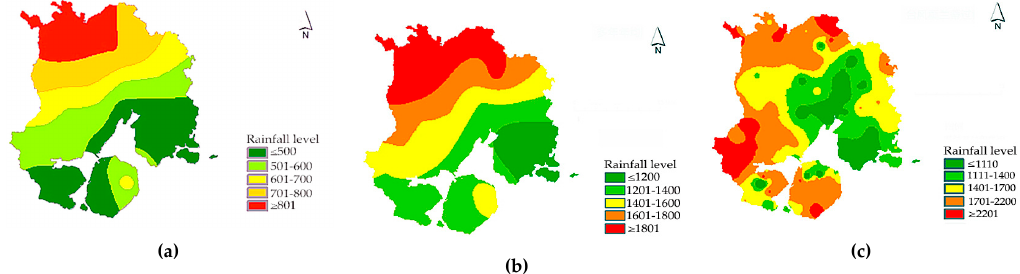
Figure 2. Simulation of precipitation in different scenarios in Xiamen: ( a ) precipitation simulation under multi-year average precipitation scenarios; ( b ) precipitation simulation under the flood season scenario; and ( c ) precipitation simulation under the typhoon transit scenario.